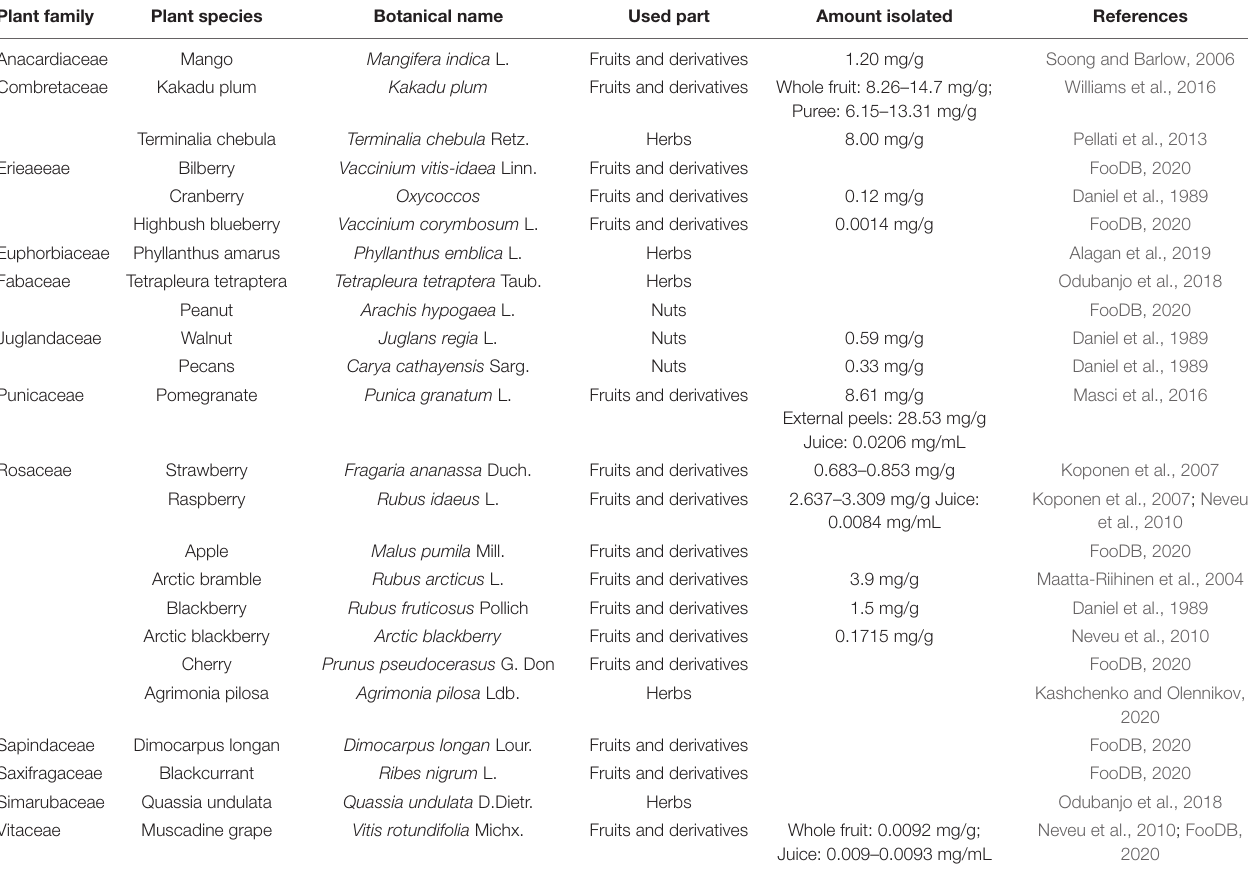
TABLE 2 | Sources of ellagic acid (EA) and its content in different fruits, nuts, and